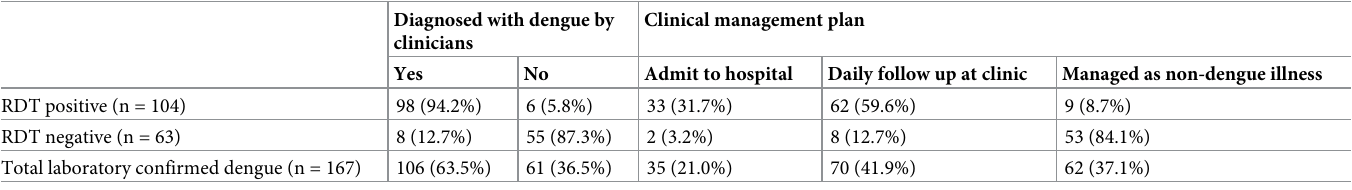
Table 2. Comparison of clinical diagnosis and management of all laboratory confirmed dengue infected patients (n = 167) who have positive RDT (n = 104) versus negative RDT test (n =